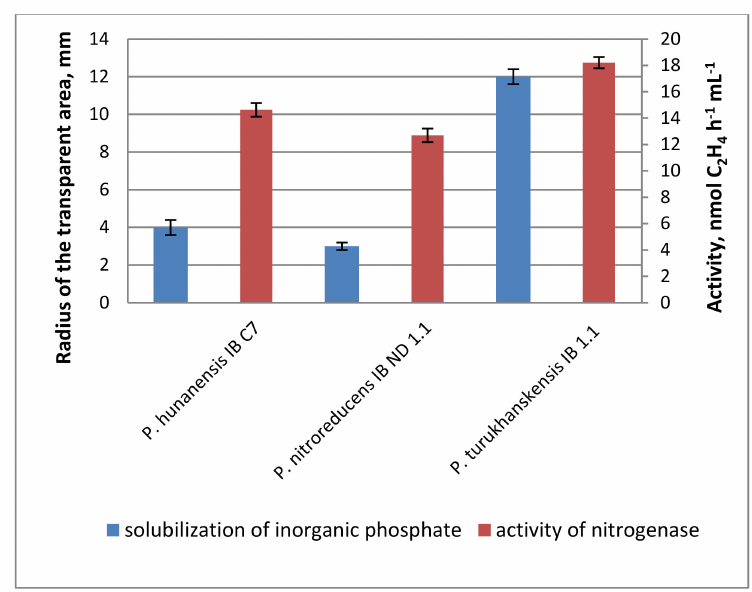
Figure 1. Solubilization of inorganic phosphate and activity of nitrogenase in liquid bacterial cultures of strains P. hunanensis IB C7, P. nitroreducens IB ND 1.1, and P. turukhanskensis IB 1.1. Mean values ± SE